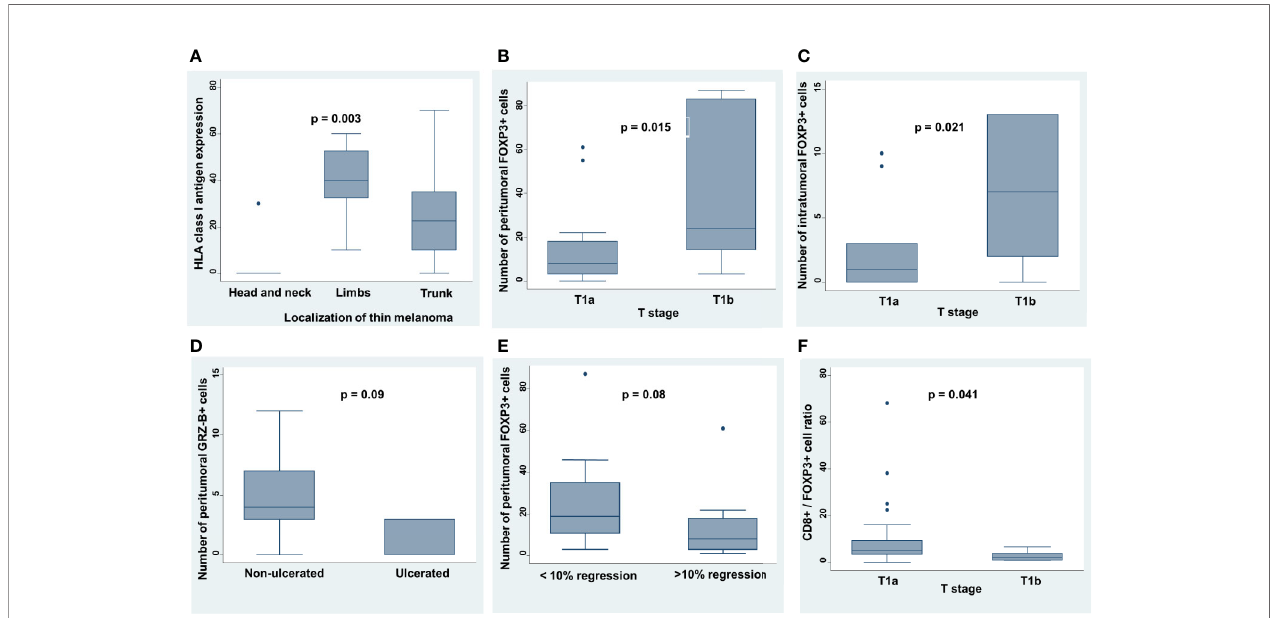
FIGURE 4 | Correlation between clinicopathological features and TIME characteristics in thin melanoma. (A) Site of primary thin melanoma was correlated to HLA class I antigen expression level by Kruskal-Wallis rank test. (B, C) T stage (sec. TNM, AJCC 8 th Edition) was correlated to the number of peritumoral and intratumoral FOXP3+ T cells by Mann-Whitney U test. (D) Presence or absence of ulceration was correlated to the number of peritumoral GRZ-B+ T cells by Mann-Whitney U test. (E) Number of peritumoral FOXP3+ T cells was correlated with presence or absence of regression at 10% cut off of extension by Mann-Whitney U test. (F) T stage (sec. TNM, AJCC 8 th Edition) was correlated to CD8+/FOXP3+ T cell ratio by Mann-Whitney U test. On each box, the central mark is the median, the edges of the box are the 25 th and 75 th percentiles, the whiskers extend to the most extreme data points note considered outliers, and outliers are plotted individually. p was considered signi fi cant if <